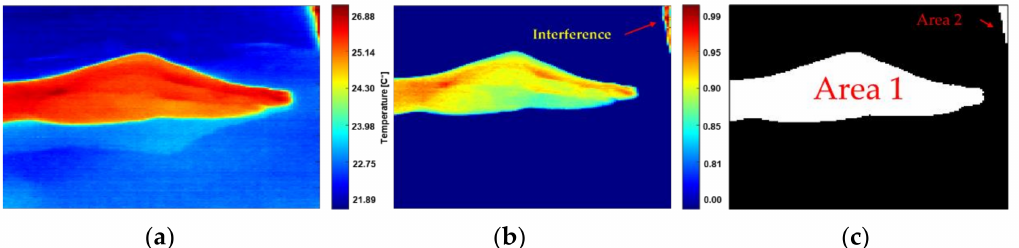
Figure 14. Illustration of the inference treatment. ( a ) Raw IR image with thermal interferences and reflection, ( b ) normalized radiometric data with interference on the corner, ( c ) area 1 and 2, correspond to warm and large areas with ∆ T < 2.6%, but only the area 1 should be labeled as